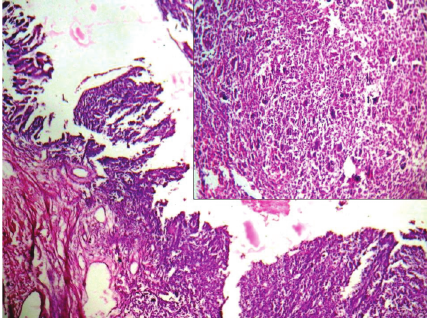
Figure 2: Microphotograph showing cyst lining and cellular mural nodule inset: SLMN with spindle-shaped stromal cells and giant cells (H and E × 100).